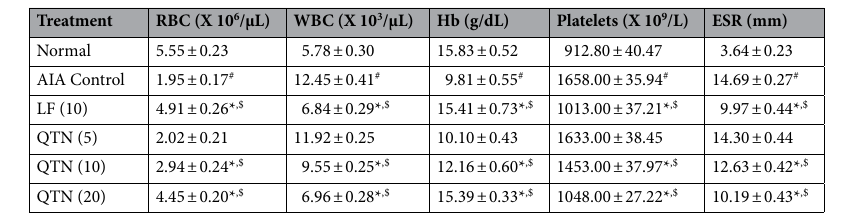
Table 3. Effects of QTN on FCA-induced alterations in hematological parameters and ESR level. Values in parentheses indicate a dose in mg/kg (n = 6). Data were analyzed by one-way ANOVA followed by Tukey’s multiple comparisons test. For comparison with AIA-control group: * p < 0.05, comparison with normal group: # p < 0.05 and comparison with one another: $ p < 0.05. AIA adjuvant-induced arthritis, LF leflunomide, QTN 3,5,7,3 ′ ,4 ′ -pentahydroxy flavone, RBC red blood cells, WBC white blood cells, ESR erythrocyte sedimentation rate.